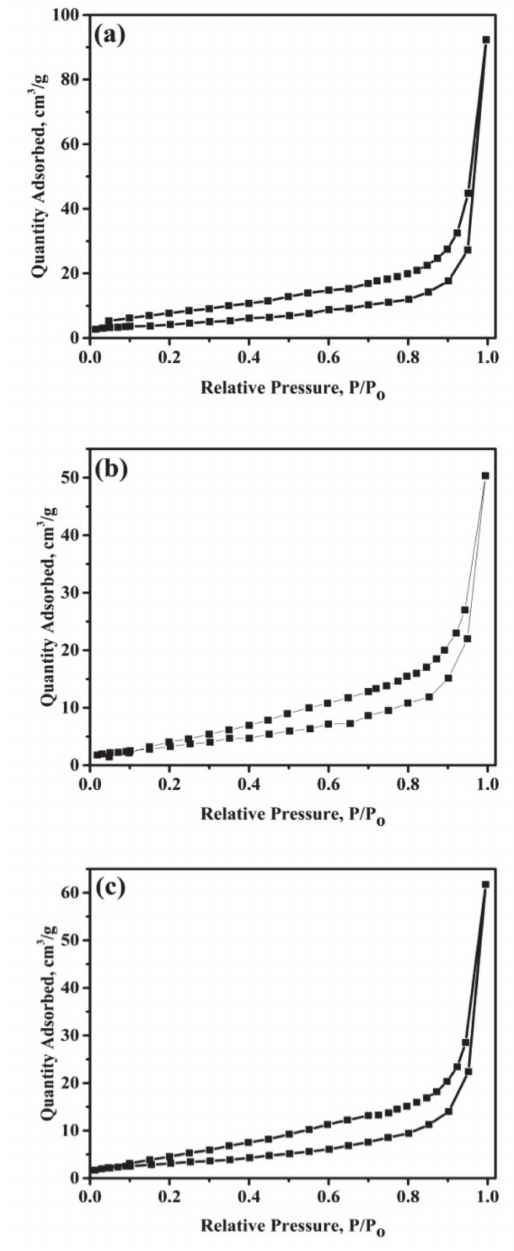
Figure 4. Nitrogen adsorption-desorption isotherms for ( a ) g-C 3 N 4 ( b ) SrAl 2 O 4 :Eu,Dy and ( c ) 50 wt.% g-C 3 N 4 supported on SrAl 2 O 4 :Eu,Dy-0.01M SiO 2